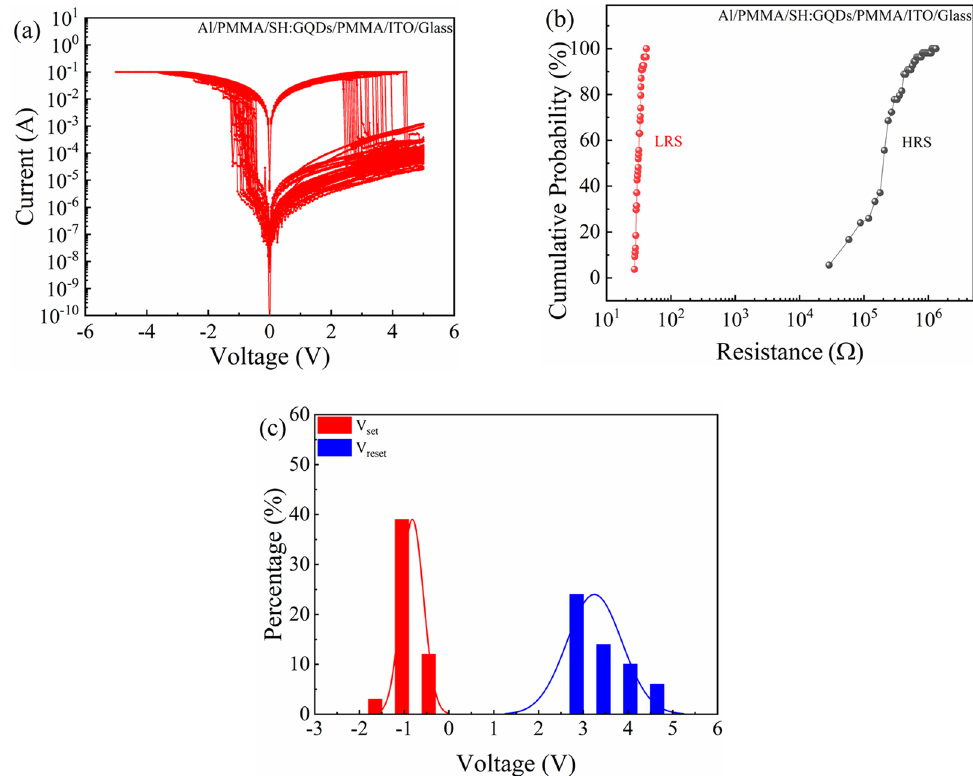
Figure 8. Al/PMMA/SH:GQDs/PMMA/ITO/glass device: ( a ) I-V characteristic curves of continuous